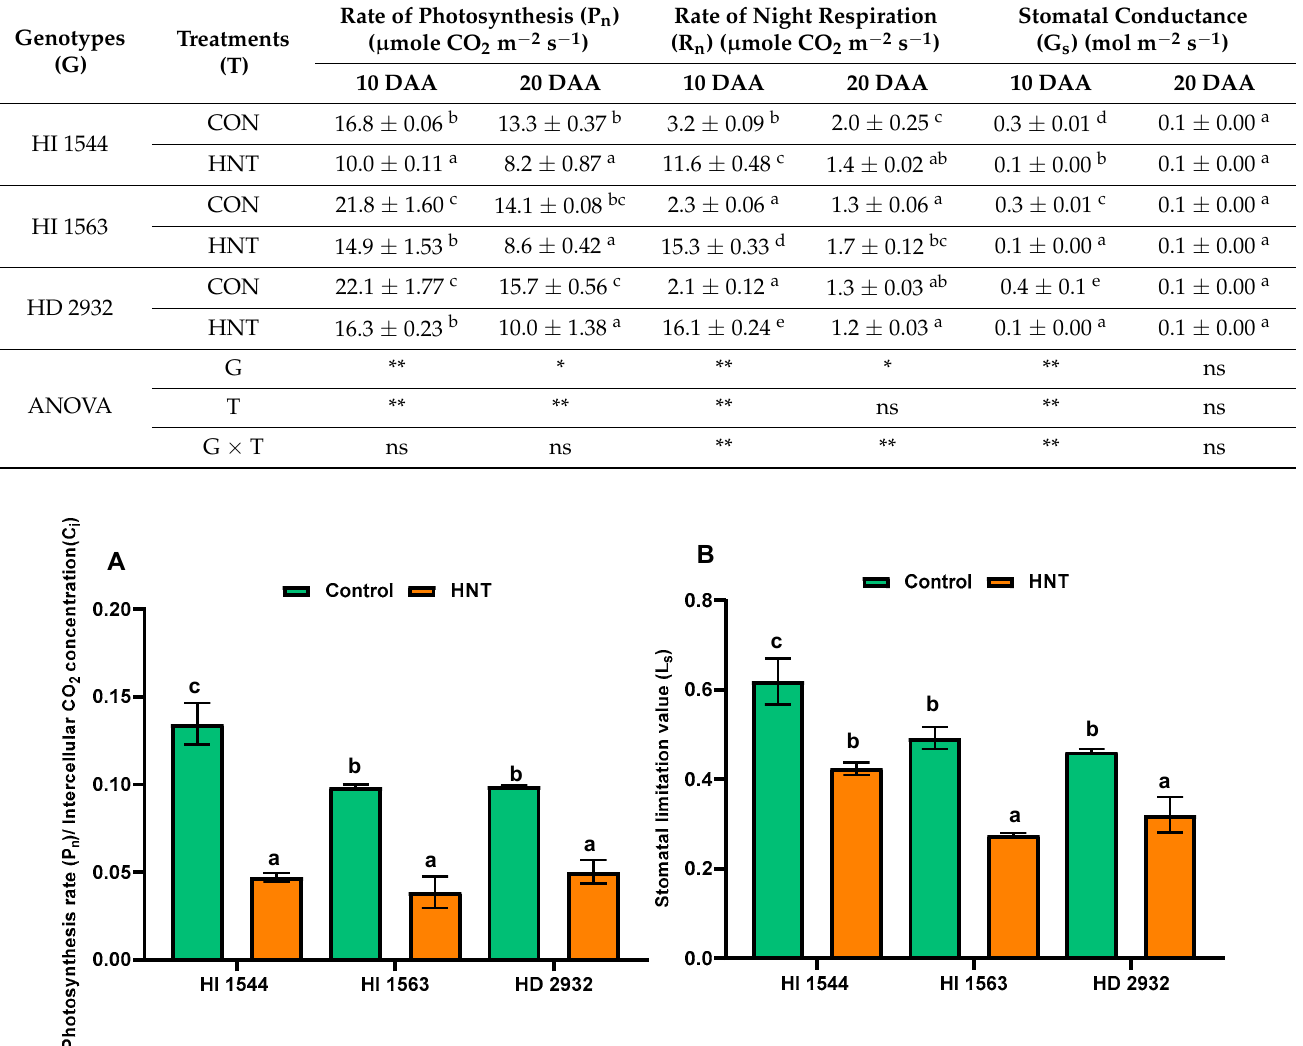
Table 1. Photosynthesis, night respiration and stomatal conductance of wheat genotypes grown under control (CON) and high night temperature (HNT) conditions. Values show mean ± SE. Data are obtained from three replications for each genotype. The separation of means was carried out using Duncan’s post hoc test ( p < 0.05). Means with different letters are significant. ** p < 0.01; * p < 0.05; ns: not significant ( p ≥ 0.05).